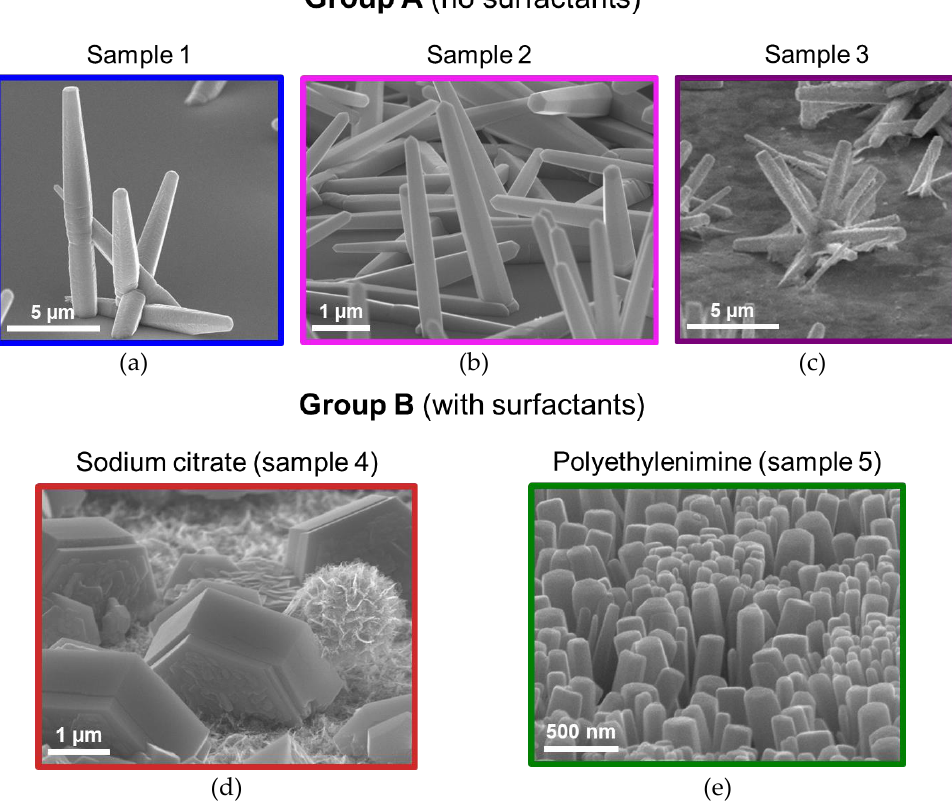
Figure 1. SEM images of the synthesized samples: ( a ) grown without surfactants, precursor concen- tration 50 mmol∙ L −1 ; ( b ) no surfactants, concentration of precursors 100 mmol∙ L −1 ; ( c ) no surfactants, concentration of precursors 300 mmol∙ L −1 ; ( d ) grown with sodium citrate, precursor concentration 100 mmol∙ L −1 ; ( e ) synthesis using PEI, precursor concentration 100 mmol∙ L −1 .